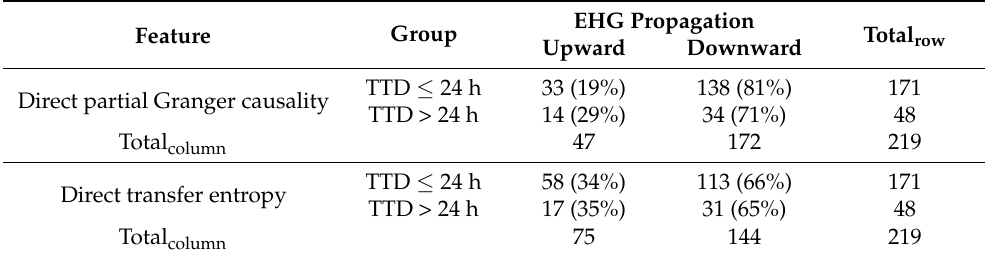
Table 3. Number (%) of pregnant women with upward or downward propagation in the group of different